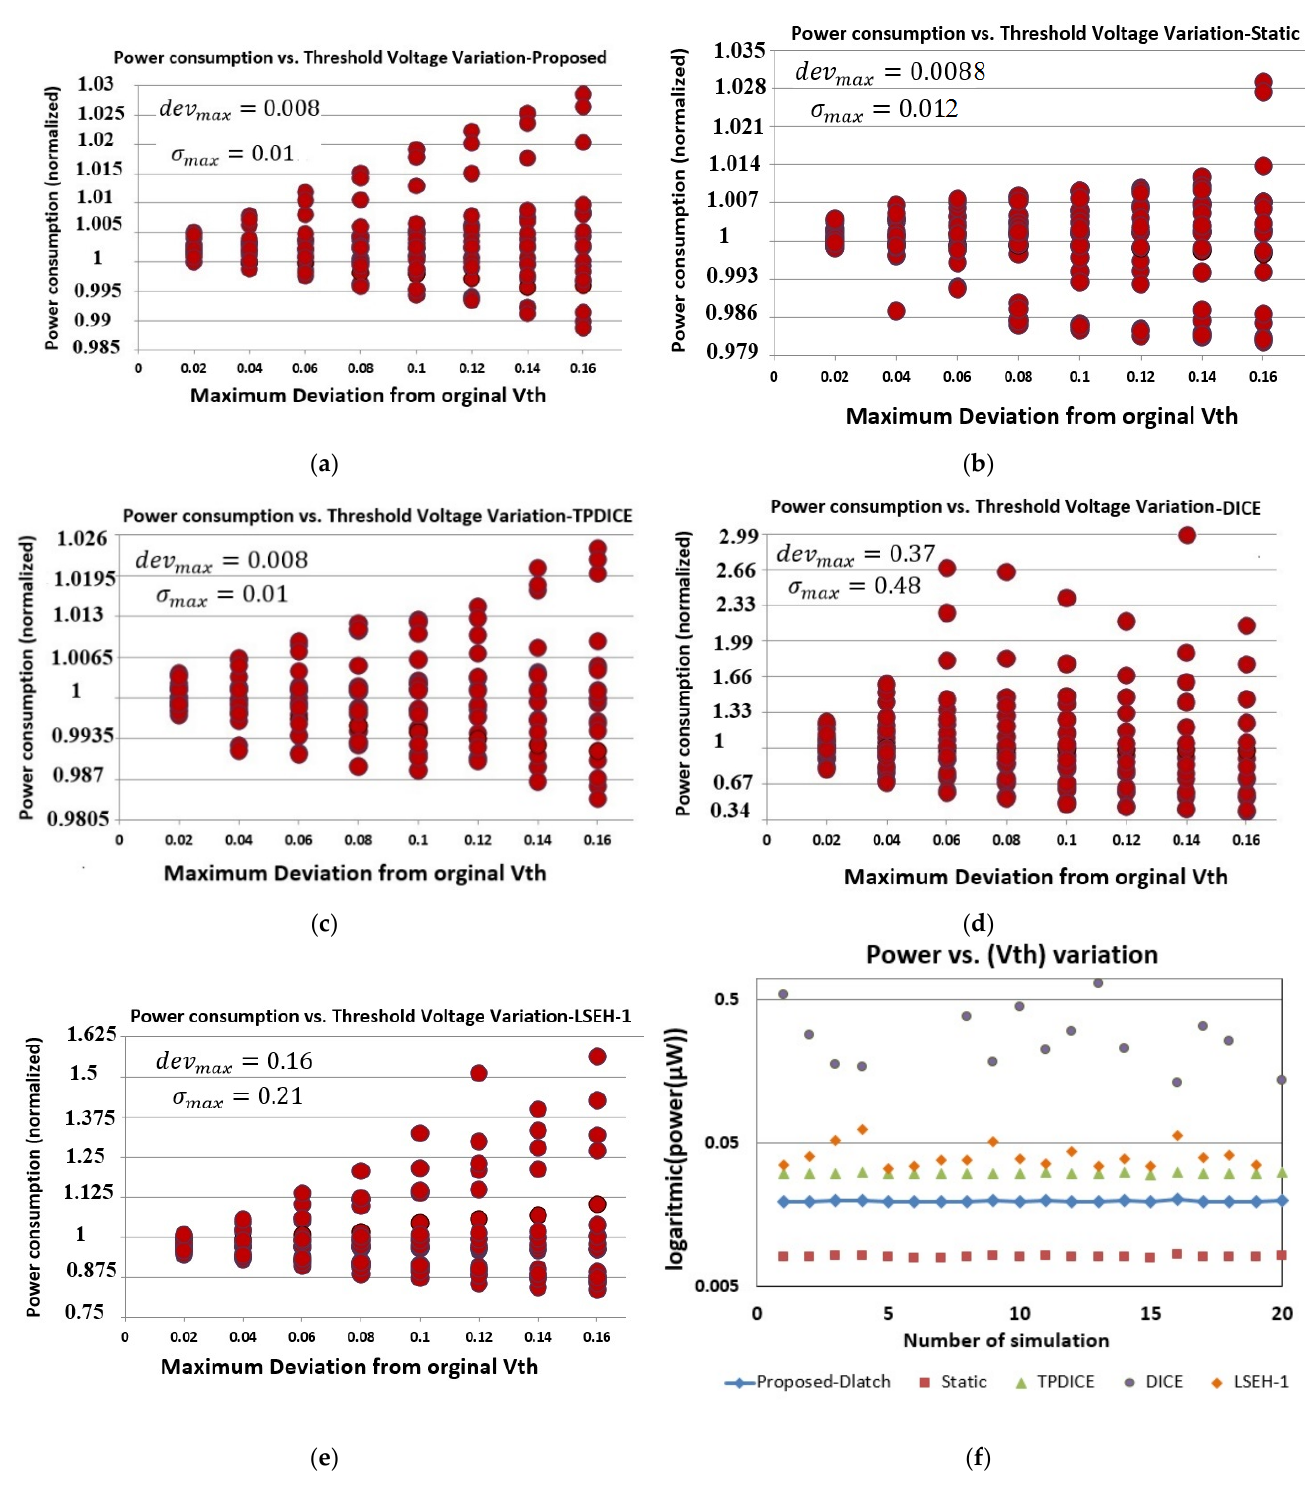
Figure 14. Threshold voltage variation effect on power consumption: ( a ) proposed D-latch ( b ) Static D-latch ( c ) TPDICE- based D-latch ( d ) DICE ( e ) LSEH-1 ( f ) power consumption of D-latches with maximum deviation, 0.16, from original threshold voltage.